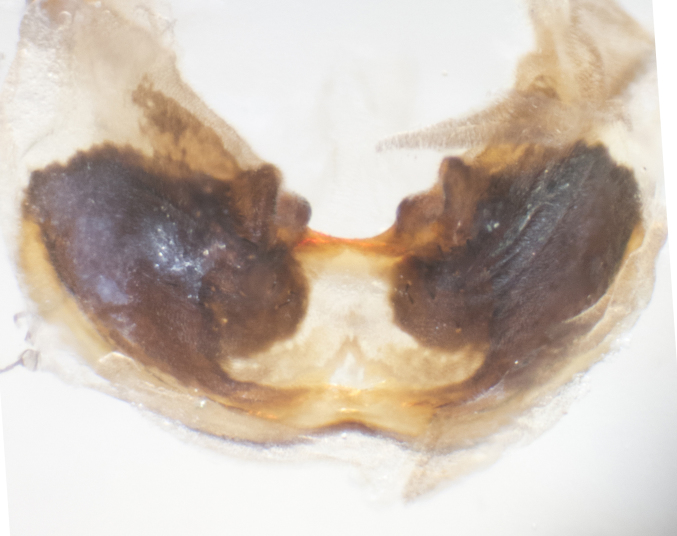
sternite 5, ventral view